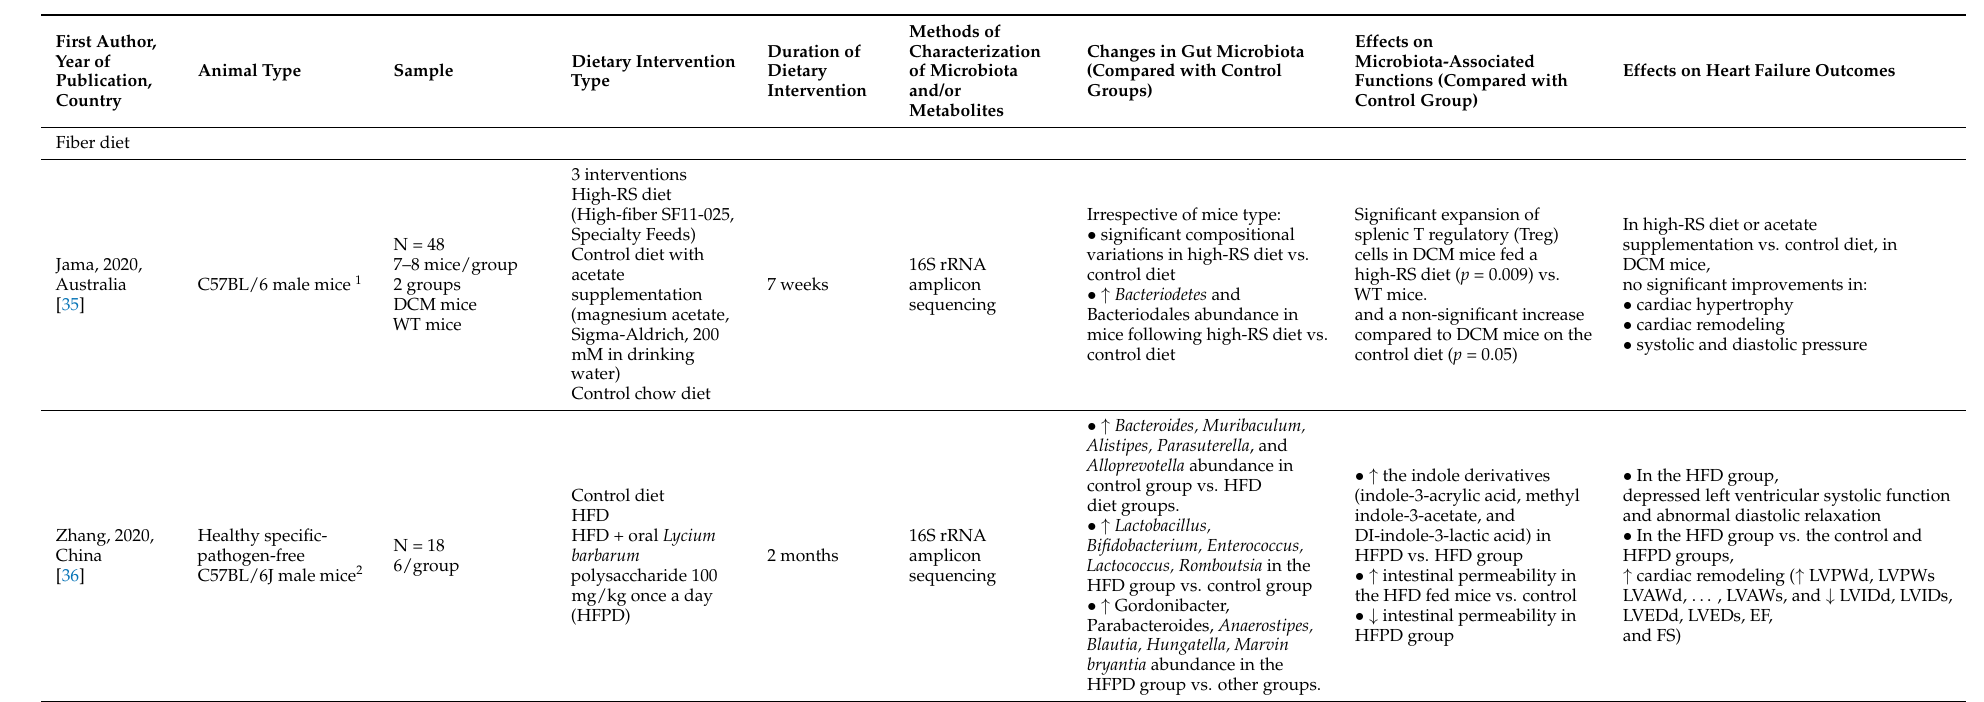
Table 2. Characteristics of included animal studies (listed by diet